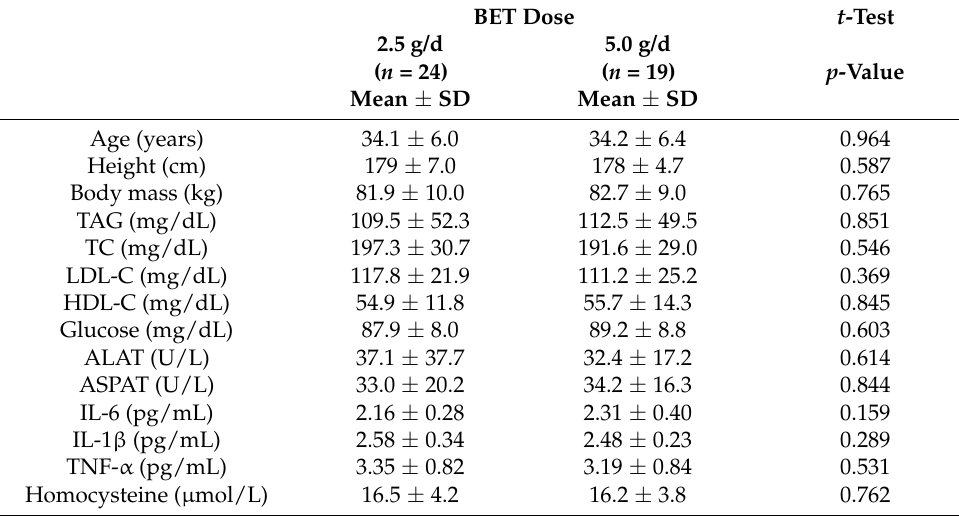
Table 1. Baseline characteristics of experimental groups.